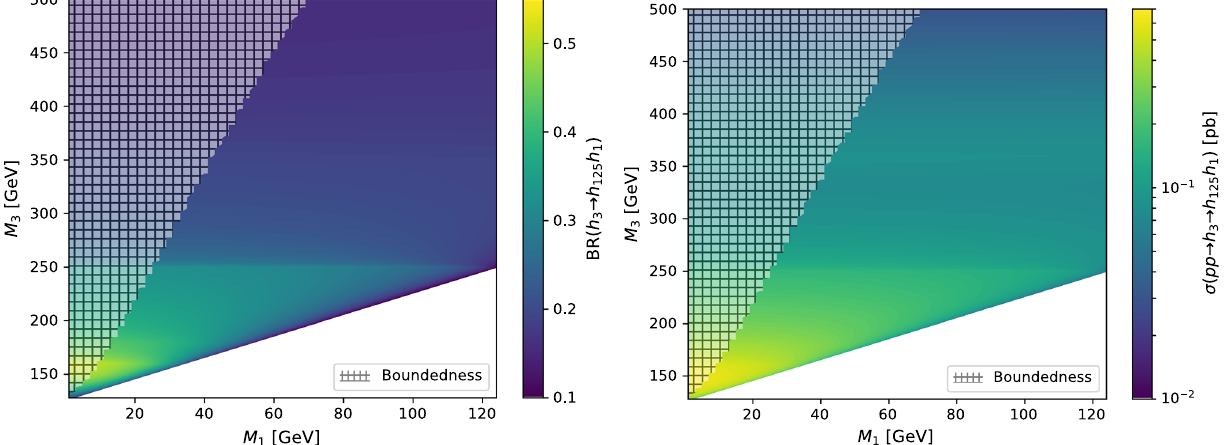
Fig. 7 Benchmark plane BP2 for the decay signature h 3 → h 1 h 125 with h 125 ≡ h 2 , defined in the ( M 1 , M 3 ) plane. The color code shows BR ( h 3 → h 1 h 2 ) (left panel) and the signal rate for pp → h 3 → h 1 h 2 (right